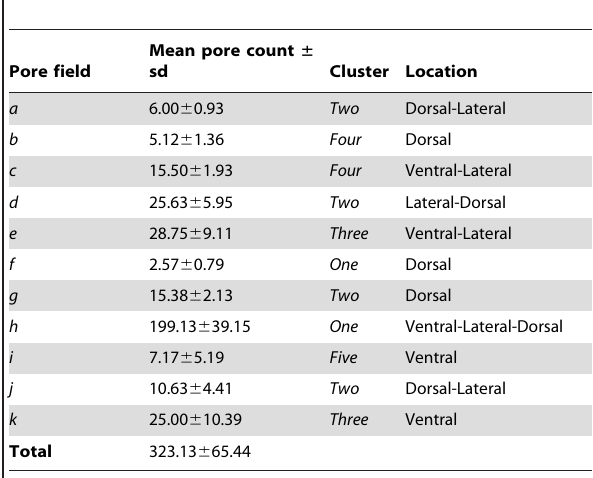
Table 1. Summary of the mean number of ampullary pores in H. ocellatum .